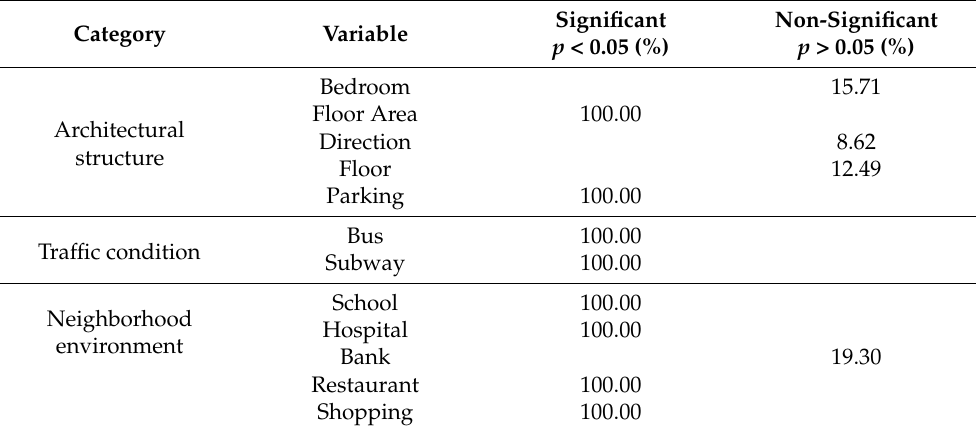
Table 6. The regression analysis results of the MGWR analysis.